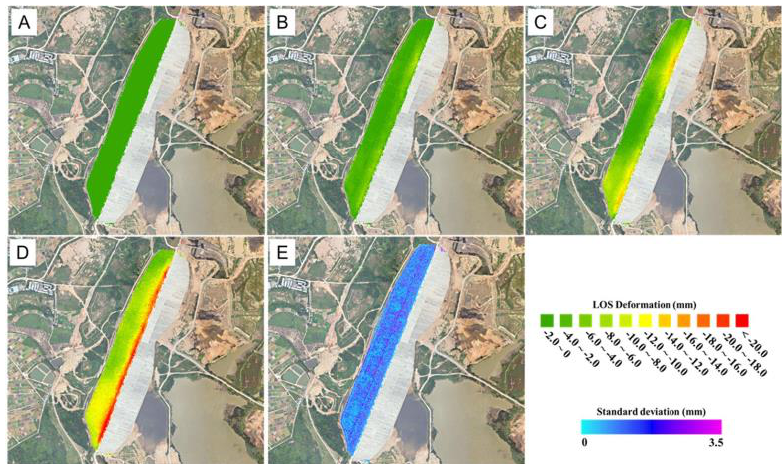
Figure 13. The deformation series results of the downstream slope in the ascending orbit TSX-SL: ( A ) date: 27/02/2017, ( B ) date: 26/05/2017, ( C ) date: 09/07/2017, ( D ) date: 05/10/2017, and ( E ) residual error